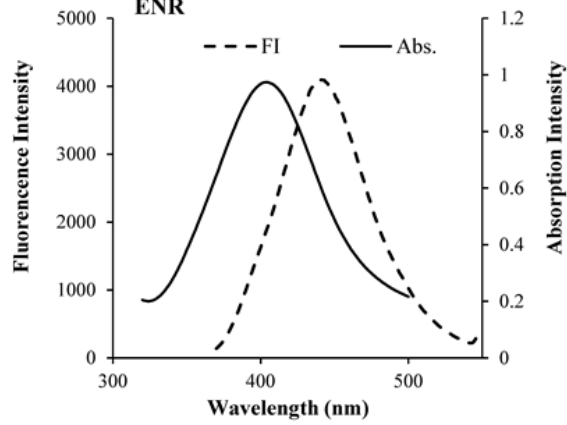
Figure 6: Fluorescence emission spectra of ENR and absorption spectra of AgNPs in water